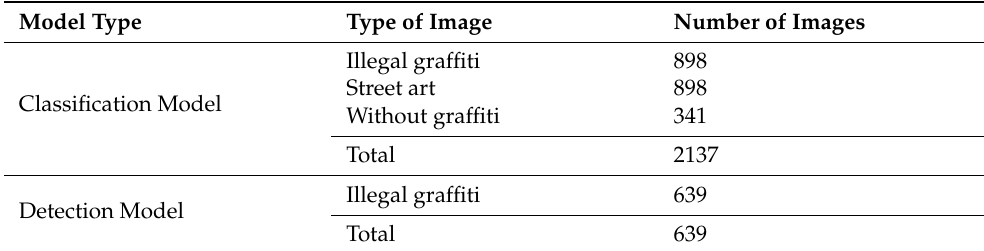
Table 3. Number of images used for each model.